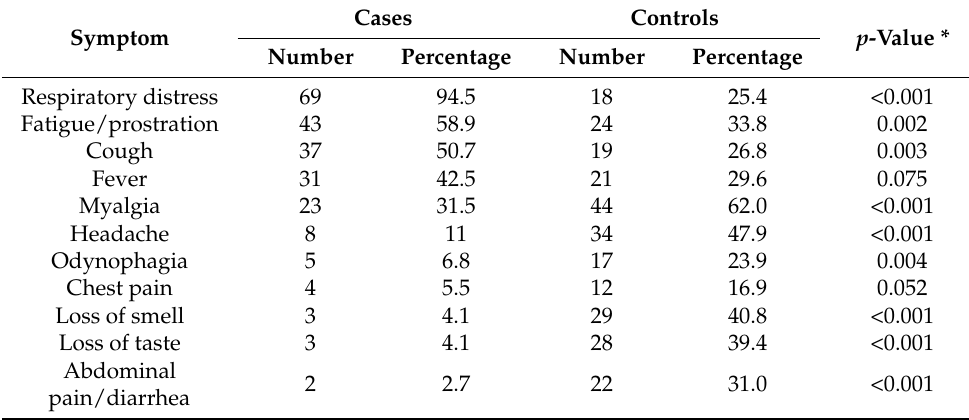
Table 2. Comparison of the frequency of symptoms between the study groups.